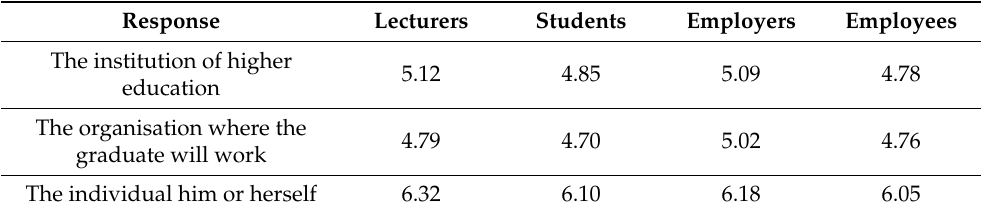
Table 9. Delegation of responsibility for developing a person’s critical thinking skills (arithmetic mean (M), where 1 is ‘strongly disagree’ and 7 is ‘strongly